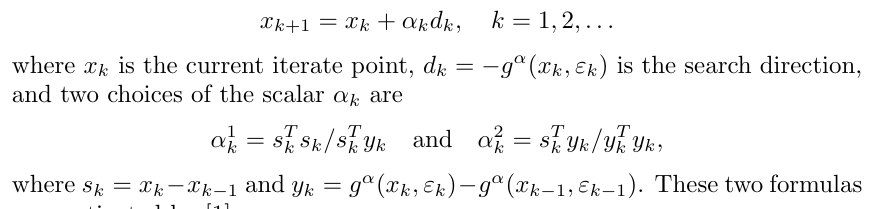
Algorithm 1. Nonmonotone Spectral Gradient